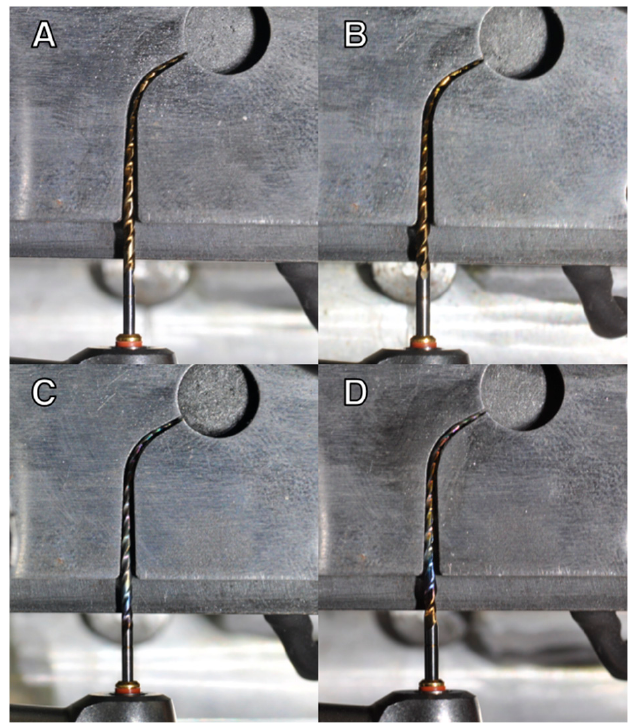
Figure 2. ( A ) TS2 T-wire 1.0, ( B ) 1.2, and ( C ) CM-wire 1.0, ( D ) 1.2 in the artificial canal with 60° angle of curvature and 5-mm radius at body temperature. of curvature and 5-mm radius at body temperature.